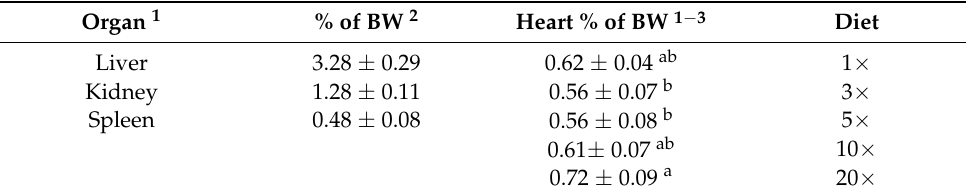
Table 6. Pup’s organ weights in experiment